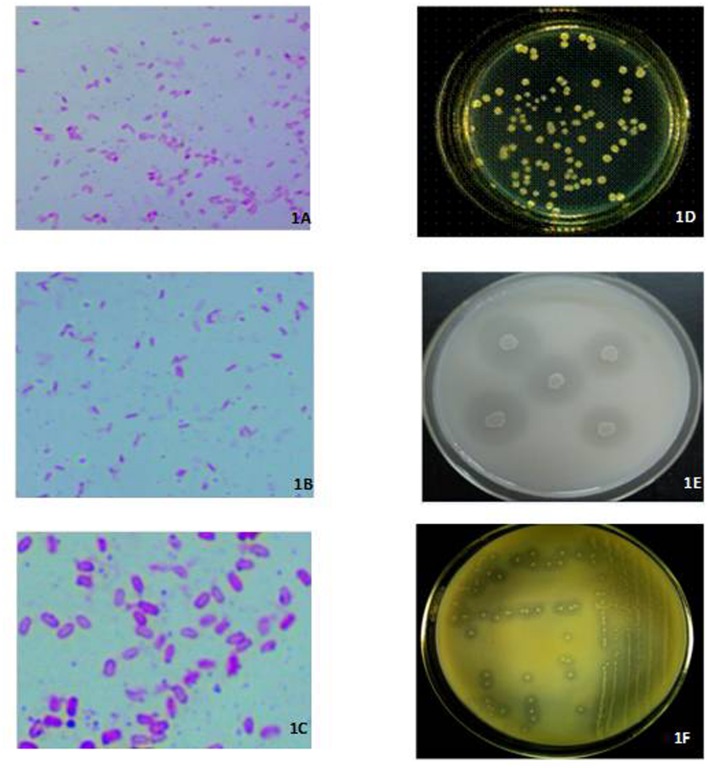
Left: Photomicrographs (1600×) of cells and spores of XD-N-3 (A), XD-P-1 (B), and XD-K-2 (C) grown on LB medium at 28°C for 3 days. Right: in vitro colonial morphology of XD-N-3 (D) grown on the Ashby medium at 28 ± 2°C after 3 days, and XD-P-1 (E), XD-K-2 (F) respectively, grown on the Pikovskaya’s and K-amended selective medium at 28 ± 2°C after 5 days. The formation of halo zone around the colonies of (E) and (F) showed the solubilization of the inorganic phosphate and potassium.